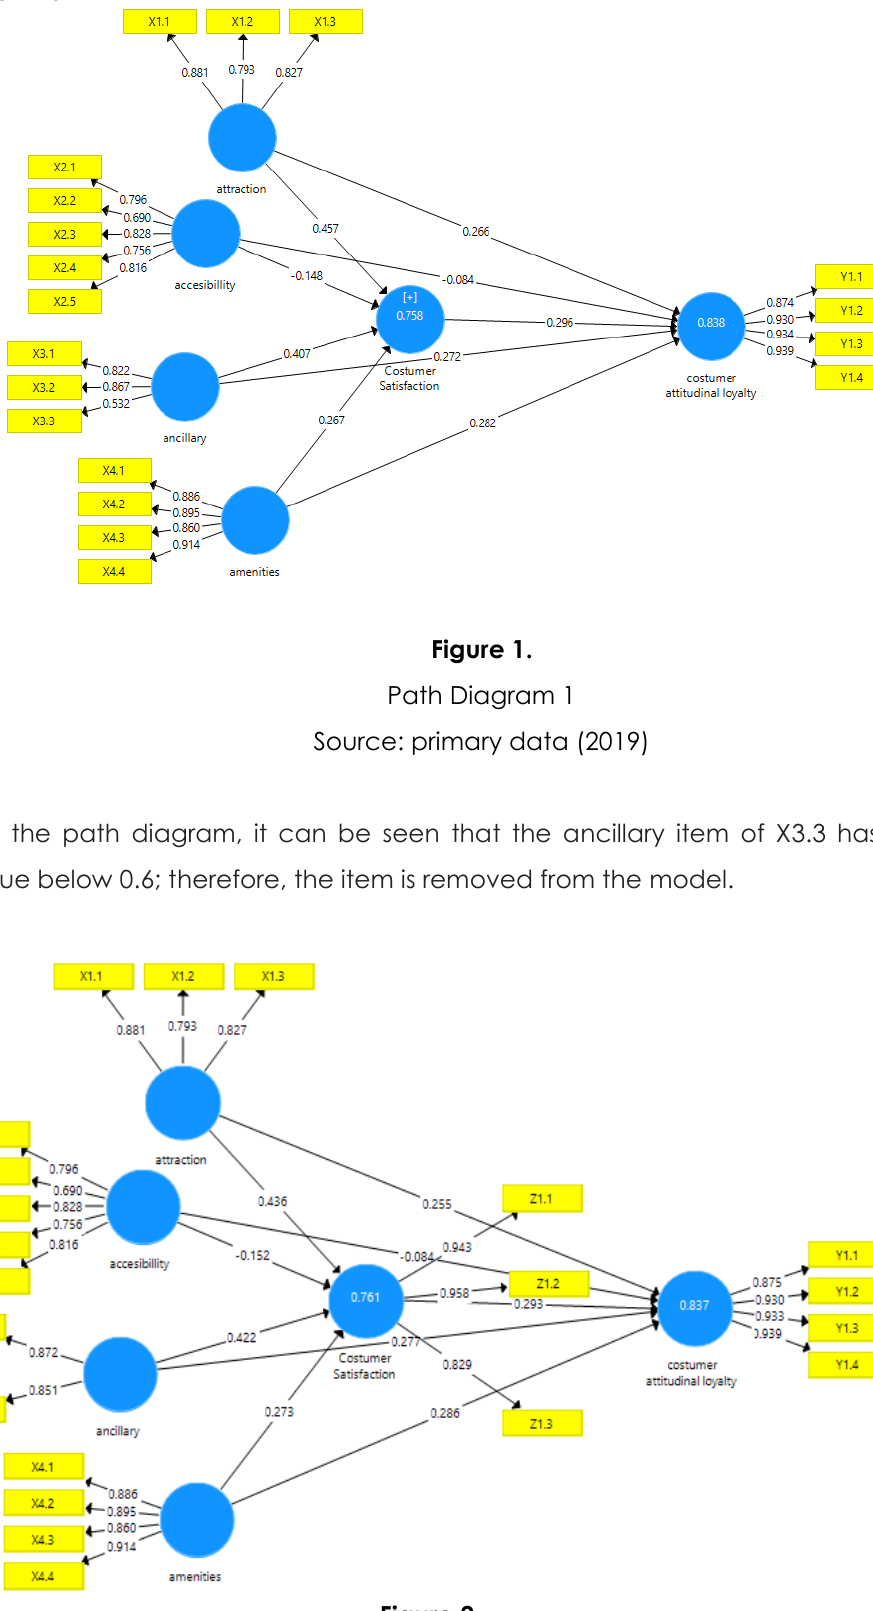
Figure 2. Path Diagram 2 Source: primary data